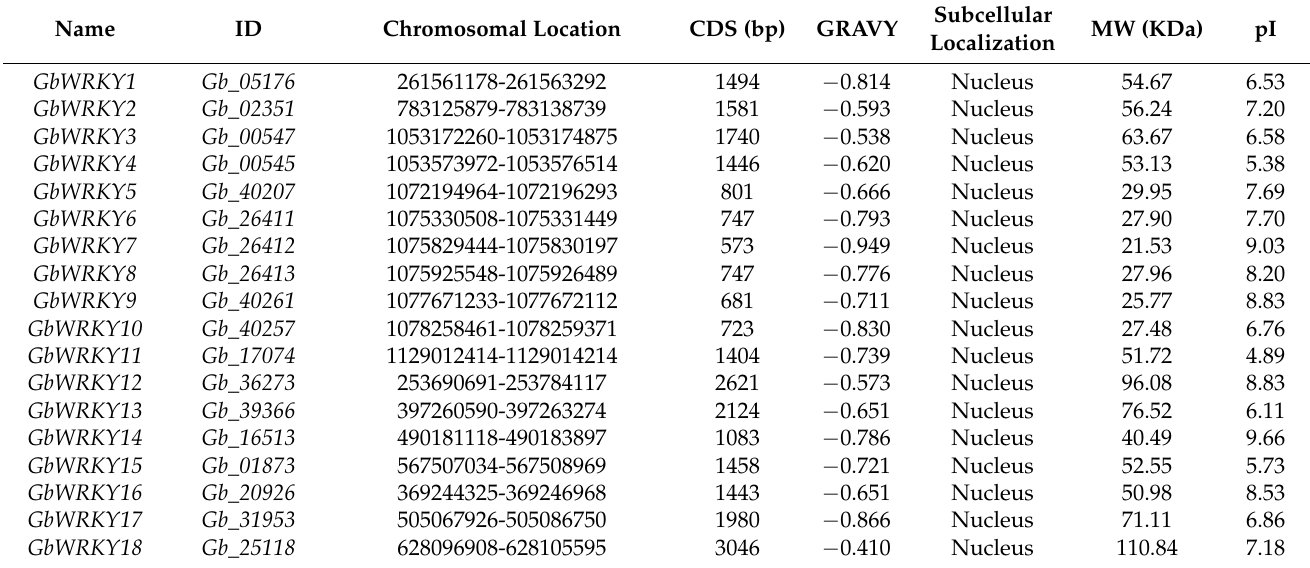
Table 1. Genome − wide identification of GbWRKY